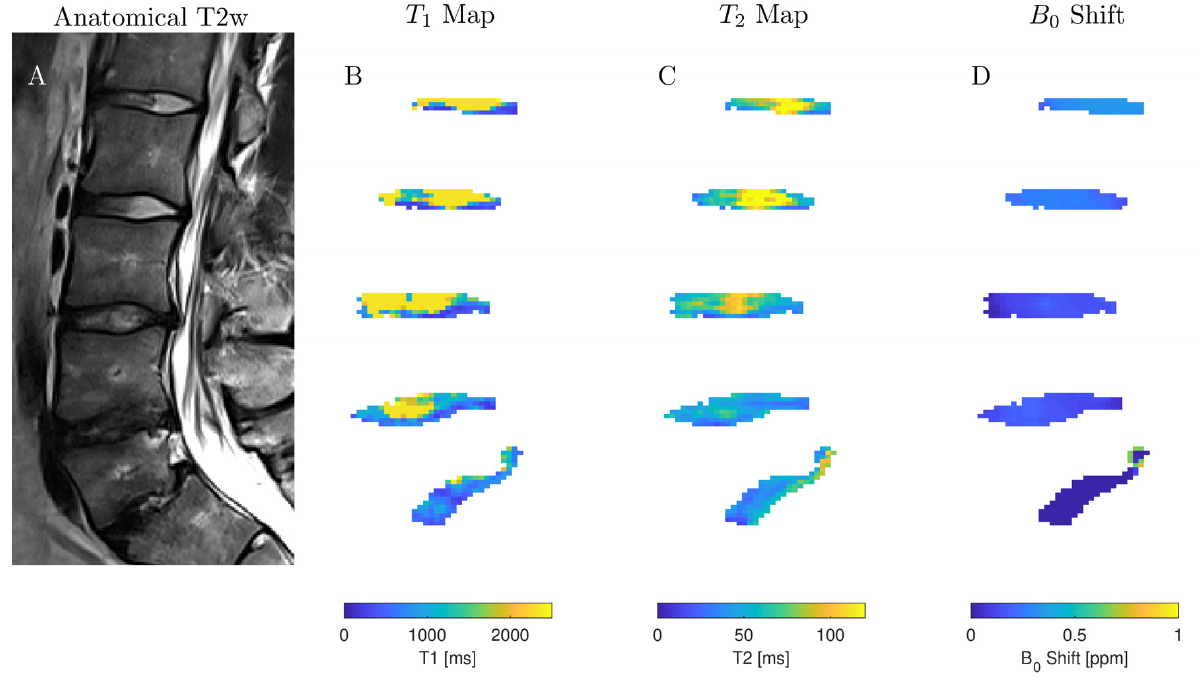
Figure A6. A sagittal T2-weighted (T2w) image ( A ) of the volunteer shown in Figure 4 and the corresponding longitudinal relaxation time (T1) map ( B ), transverse relaxation time (T2) map ( C ), and B0 field displacement map ( D